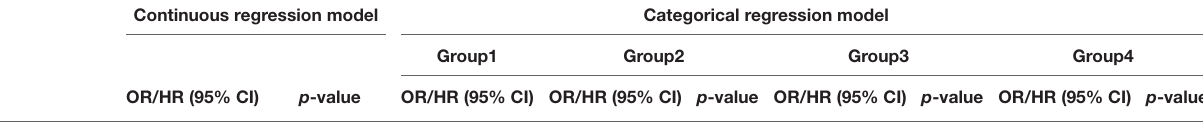
TABLE 2 | Analysis of the associations between outcomes and